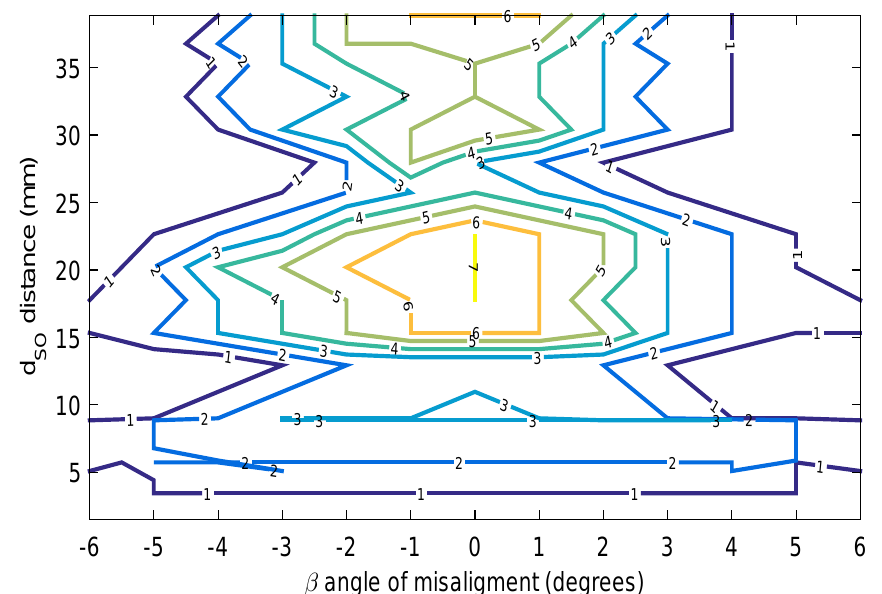
Figure 5. Contour graph that shows the number of O n echoes between the echoes I 1 and I 2 , varying the d SO distance and the β